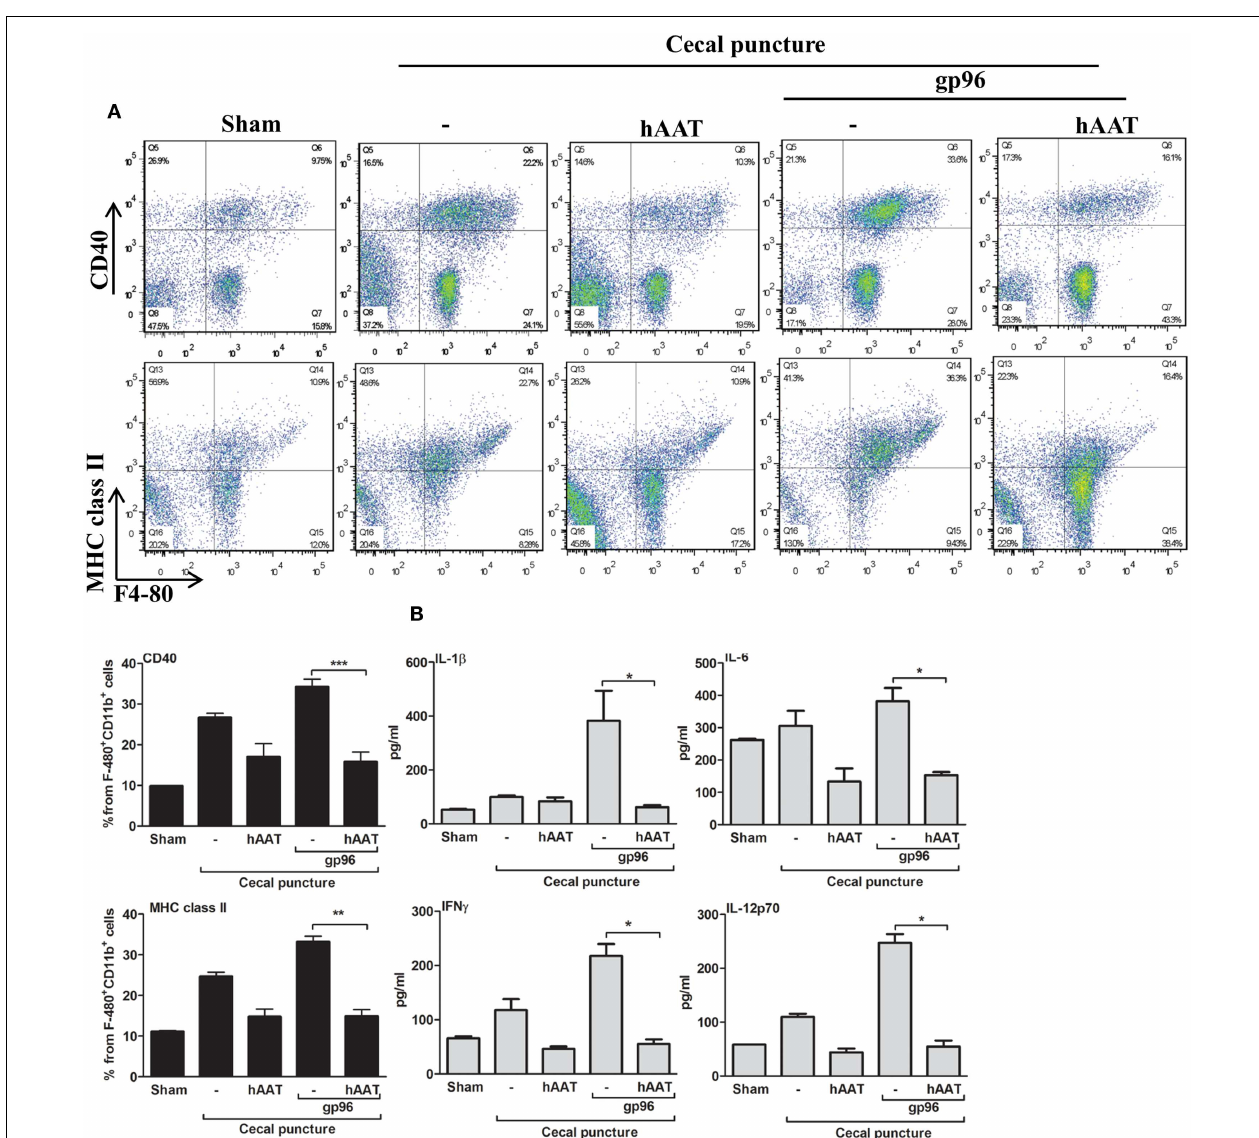
FIGURE 2 |The effect of hAAT on inflammatory responses during the cecal puncture (CP) model . CP was performed by inflicting a uniform-size at a constant position of the cecum in mice that were divided into the following groups: untreated sham-operated mice (Sham, n = 2), untreated CP-operated mice ( n = 4), mice pretreated with hAAT (60mg/kg), and then CP-operated ( n = 5), and CP-operated mice that were also introduced with recombinant gp96 (80 µ g/kg i.p., once, 24h after the surgical procedure).